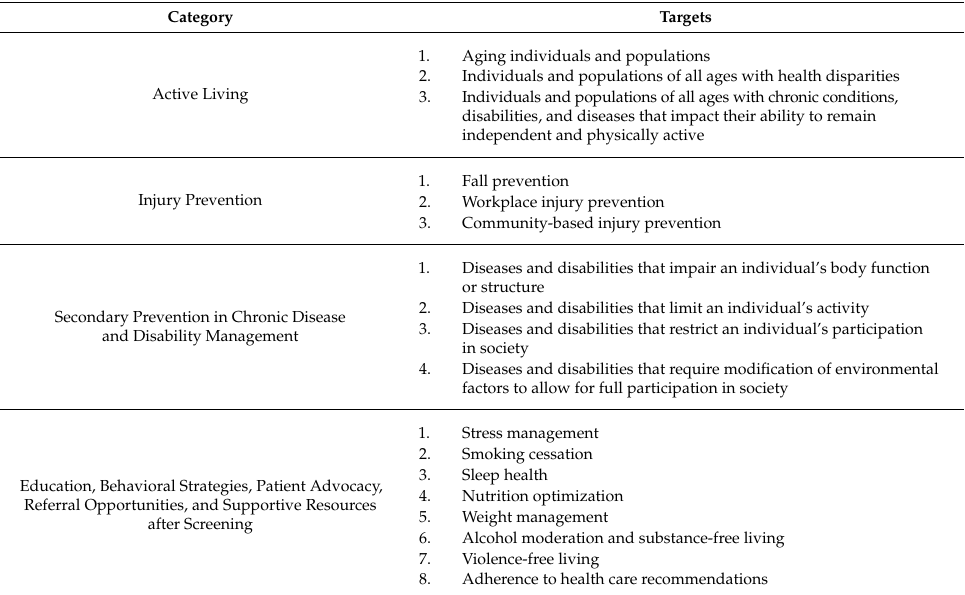
Table 2. American Physical Therapy Association (APTA) position: health priorities for populations and individuals